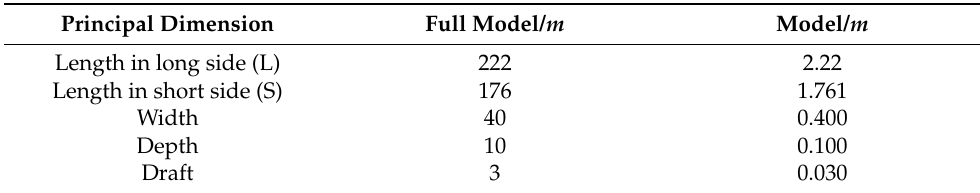
Table 1. Main Dimensions of Trapezoidal VLFS Model.